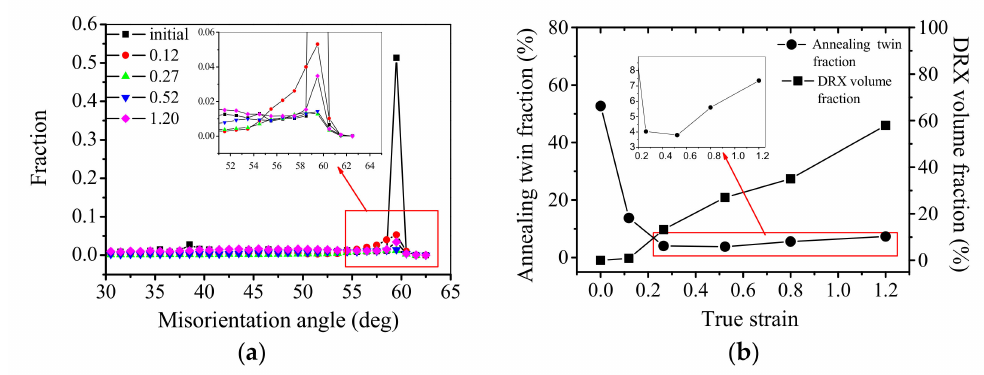
Figure 5. Changes of annealing twin fraction and DRX volume fraction at the deformation temper- ature of 1223 K and strain rate of 0.01 s − 1 : ( a ) misorientation angle distribution; ( b ) variations of annealing twin fraction and DRX volume fraction with strain.